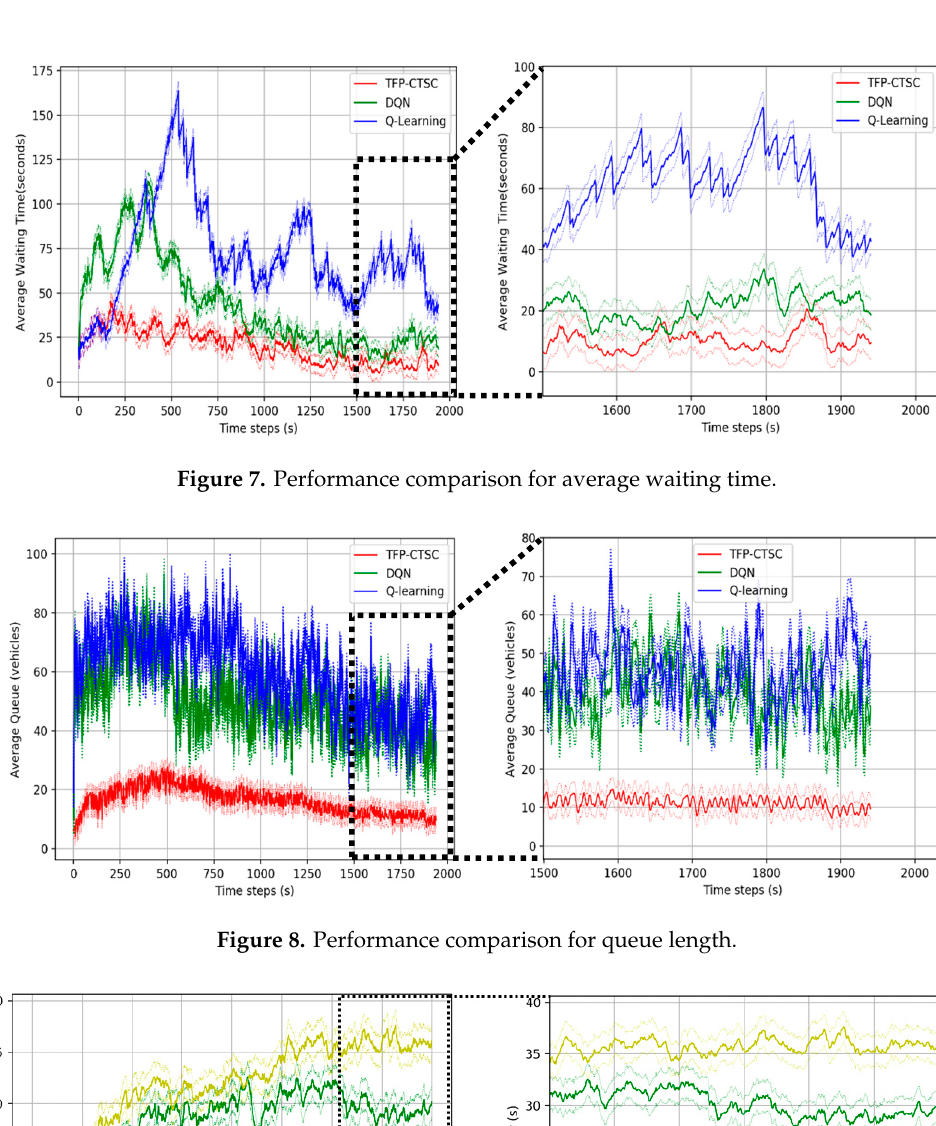
Figure 10. Performance comparison with TFP-CTSC without CTSC and TFP. ( a ) Average waiting time; ( b ) queue length. 5.3.3. Comparative Analysis of Reward Function In this experiment, we compare the performance of the model according to how we define the reward function. The object of comparison is the reward function which considers only waiting time and the reward function, which considers both waiting time and queue length. Figure 11 shows the average reward at each intersection of two reward functions. The reward function considering only waiting time showed a high average reward at all intersections. This means that the reward function we defined has high performance and how to design the reward function is important.